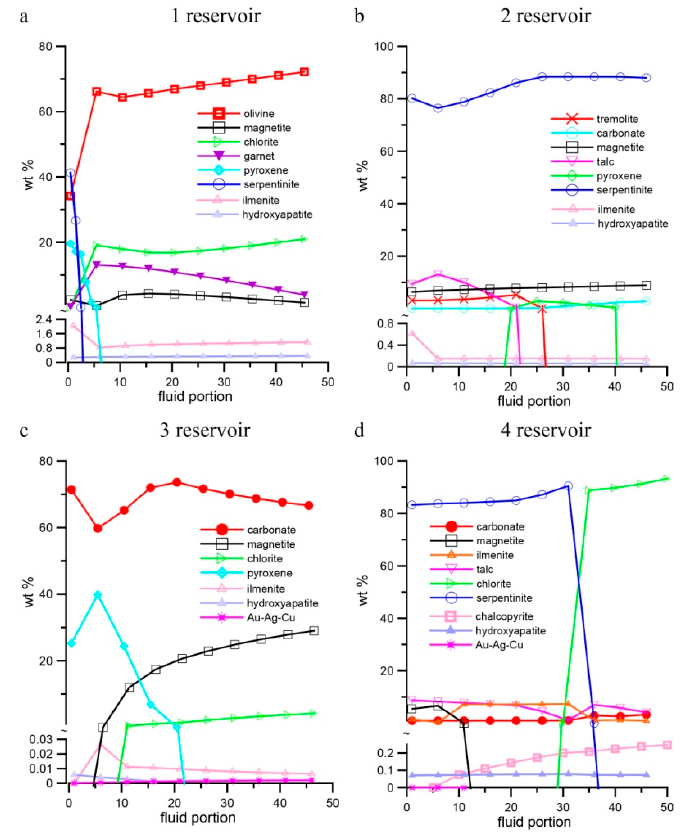
Figure 10. ( a – d ) Changes in the mineral composition of model reservoirs 1–4, respectively, as the amount of incoming fluid increases.